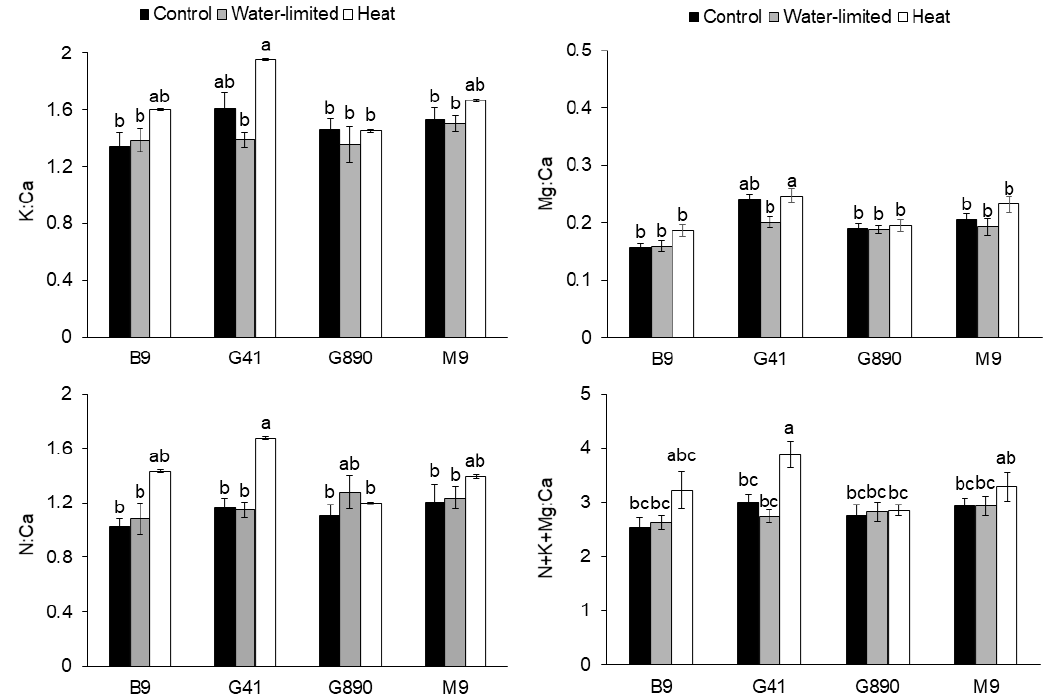
Figure 6. Mineral nutrient ratios (K:Ca, N:Ca, Mg:Ca and N + K + Mg:Ca) for leaves of apple rootstocks B9, G41, G890, and M9 grown under water-limited or elevated soil temperature treatments compared to an untreated control. Error bars denote standard error ( n = 3). Letters denote significant differences among means determined using a Tukey’s mean separation test ( α = 0.05).